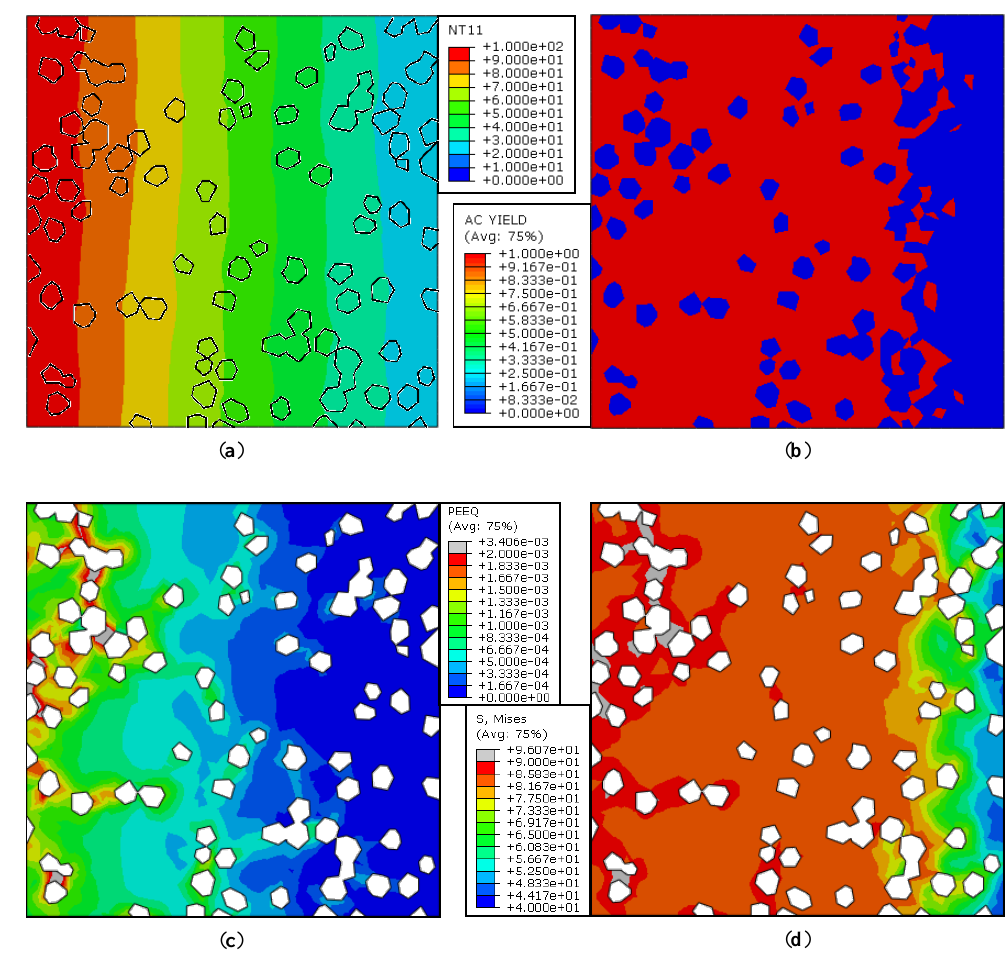
Figure 5. Steady-state analysis without interacting surfaces (Case 1): Contours of ( a ) Nodal temperature (°C); ( b ) Active yielding; ( c ) Equivalent plastic strain; ( d ) Mises equivalent stress (MPa).